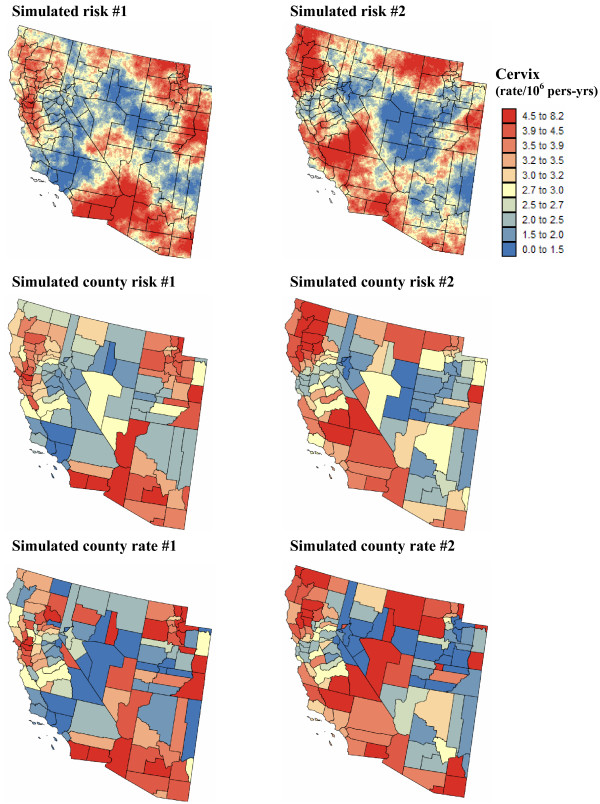
County maps of cervix cancer mortality rates simulated under two scenarios for the underlying continuous risk map. The number of cases for each county was simulated by random sampling of a Poisson distribution that is defined by the white female population map of Figure 1 and the county-level aggregation of a continuous risk map generated using sequential Gaussian simulation. The units are age-adjusted mortality rates per 100,000 person-years. The color legend applies to all the maps; the class boundaries correspond to the deciles of the histogram of original rates.